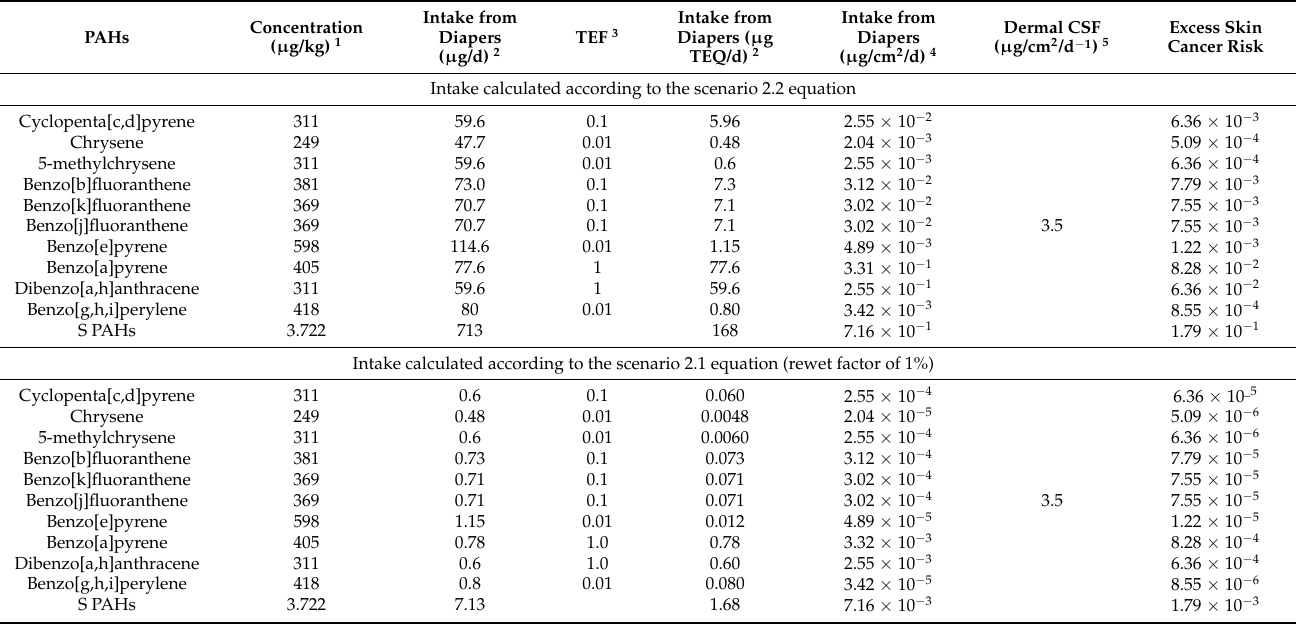
Table 6. Risk of skin cancer from polycyclic aromatic hydrocarbons (PAHs) in diapers assessed using the scenario 2.2 equation or the scenario 2.1 equation incorporating a rewet factor of 1%.